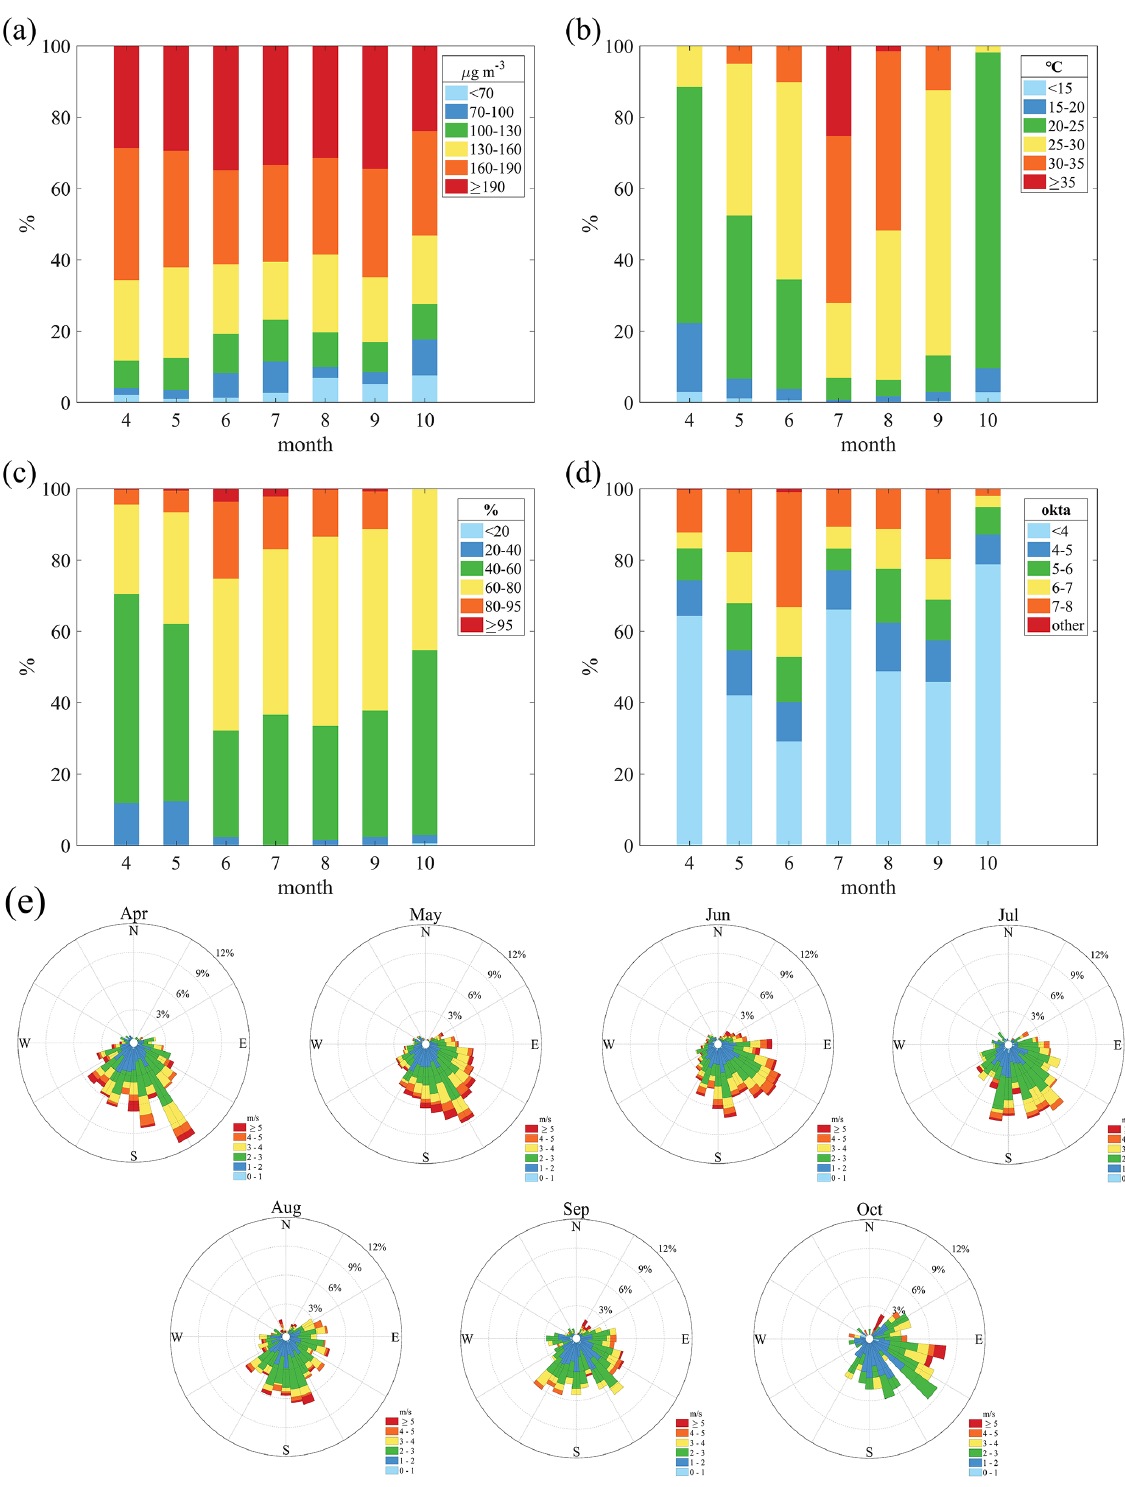
Figure 4. The monthly distributions of (a) MDA8 O 3 , (b) temperature, (c) relative humidity, (d) cloud cover, and (e) wind speed and direction during the daytime (08:00 to 20:00LT) when regional O 3 pollution occurs in the YRD.